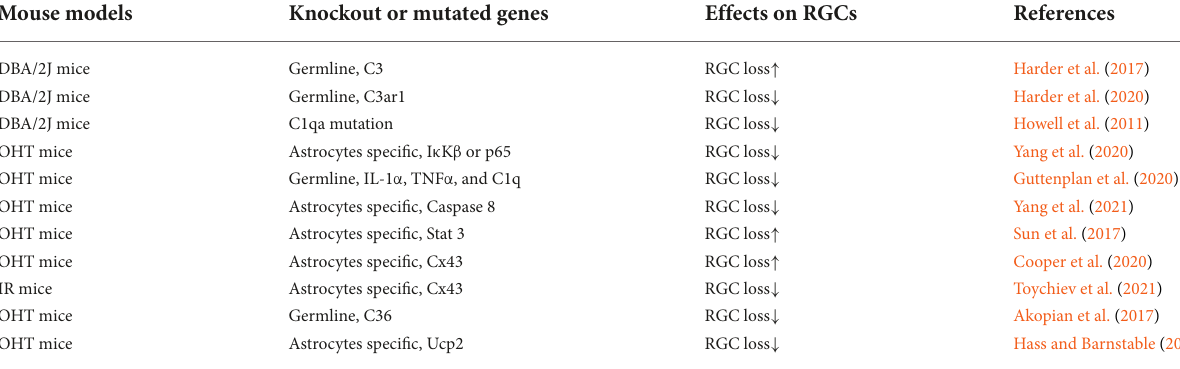
TABLE 4 Gene knockout studies in glaucoma or IR mouse